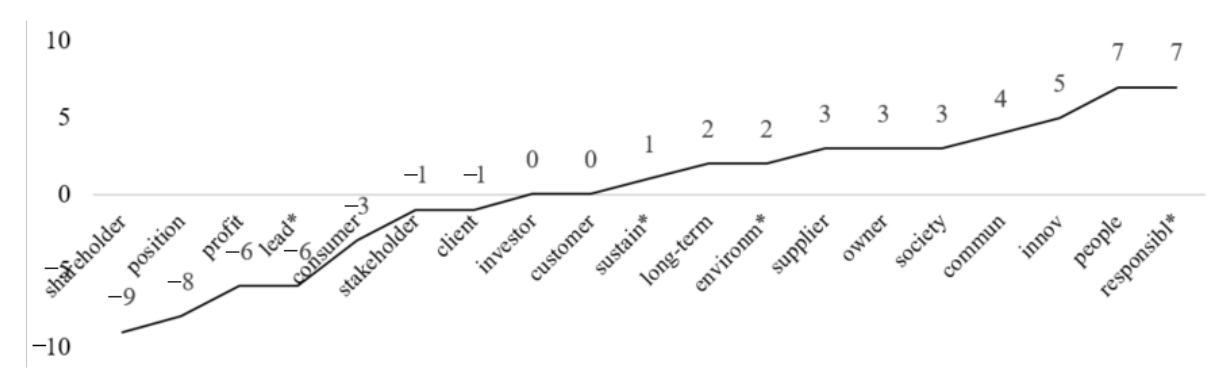
Figure 3. Results of the like-for-like mission statement analysis summarizing the changes in topic occurrence in the company mission statements over the time period from 2012 to 2021—created by authors.